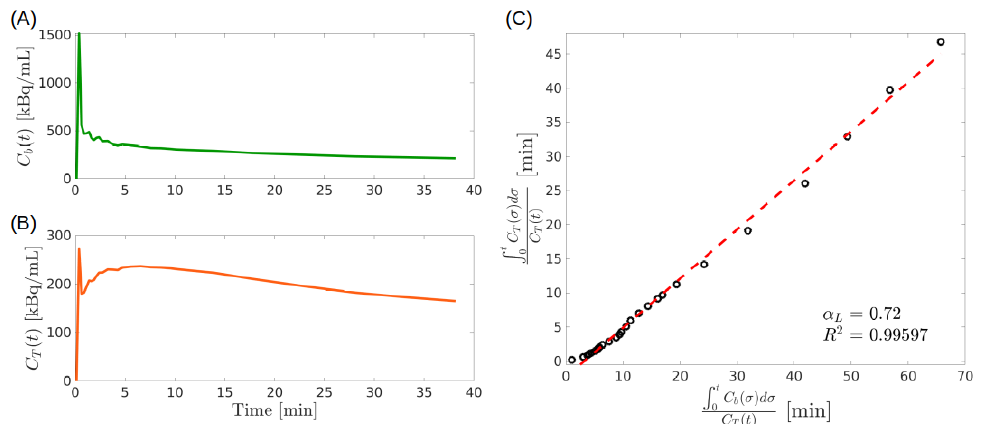
Figure 4. Illustrative example of the Logan graphical approach. ( A ) Experimental input function C b ( t ) as a function of time. ( B ) Simulated total concentration C T ( t ) as a function of time. ( C ) Logan plot (black circles). The red dotted line is the results of a linear regression model fitted to the points of the plot. The value of the corresponding slope α L and of the coefficient of determination R 2 are also